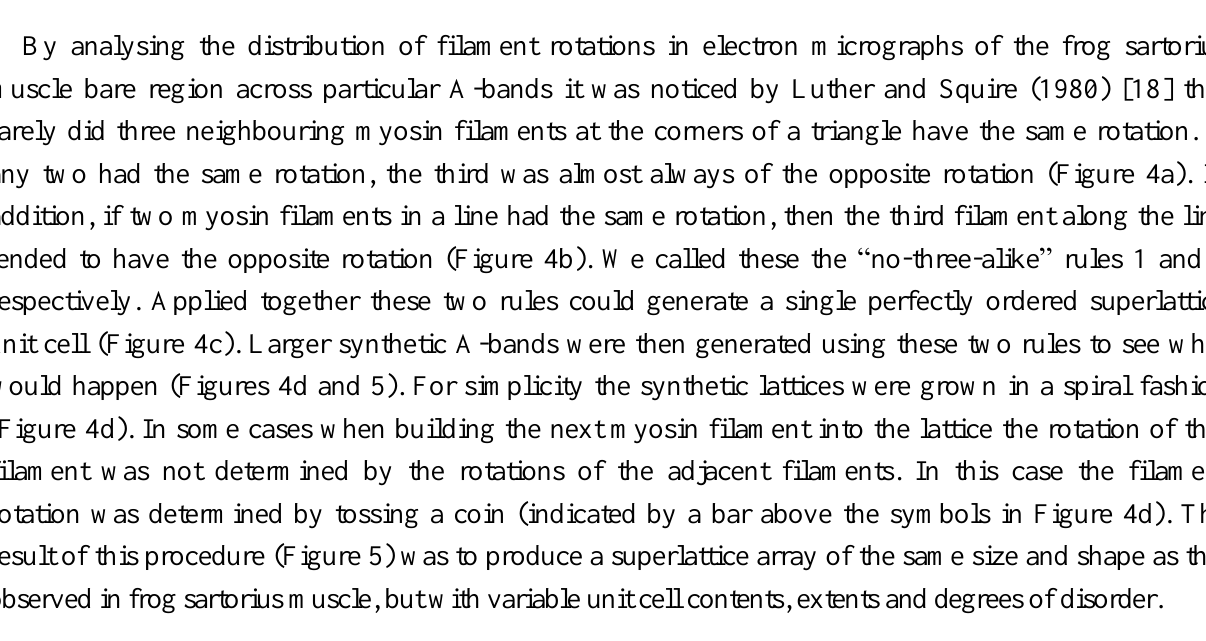
Figure 4. Illustrations of the applications of the no-three-alike rules. ( a ) Rule 1: Three adjacent filaments forming a triangle cannot all have the same orientation. ( b ) Rule 2: Three filaments along a row of the hexagonal lattice cannot all have the same orientation. ( c ) Applying these two rules gives rise to a superlattice unit cell. ( d ) Generation of a synthetic bare region. Symbols 0 and 1 represent the two myosin filament rotations (0° and 60°). The lattice was generated by travelling along a spiral from the centre A. A bar